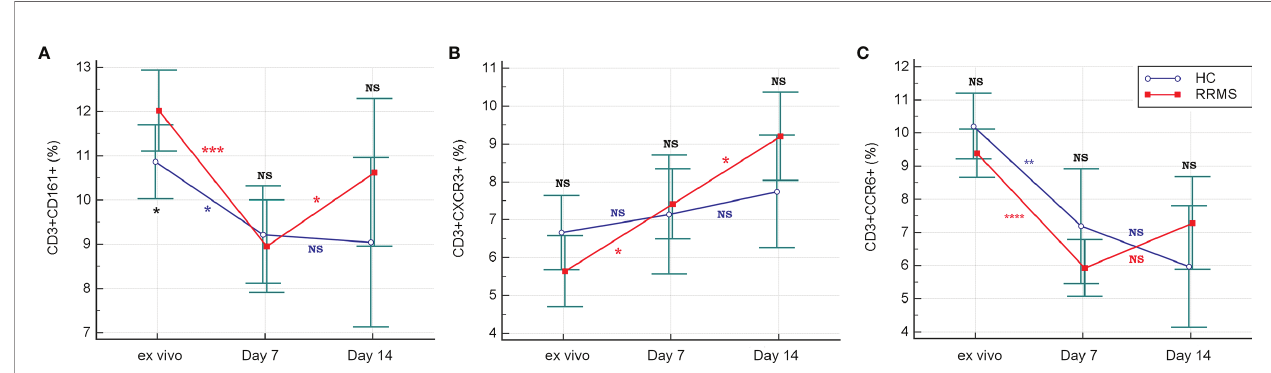
FIGURE 4 | The evolution of CD3+ cells expressing CD161 (A) , CXCR3 (B) and CCR6 (C) receptors in ex vivo samples to 7 and 14 days in culture with rh-IL2. Signi fi cance levels are graphically represented as follows: NS, non signi fi cant, p >0.05, * p <0.05, ** p <0.01, *** p <0.001, ****